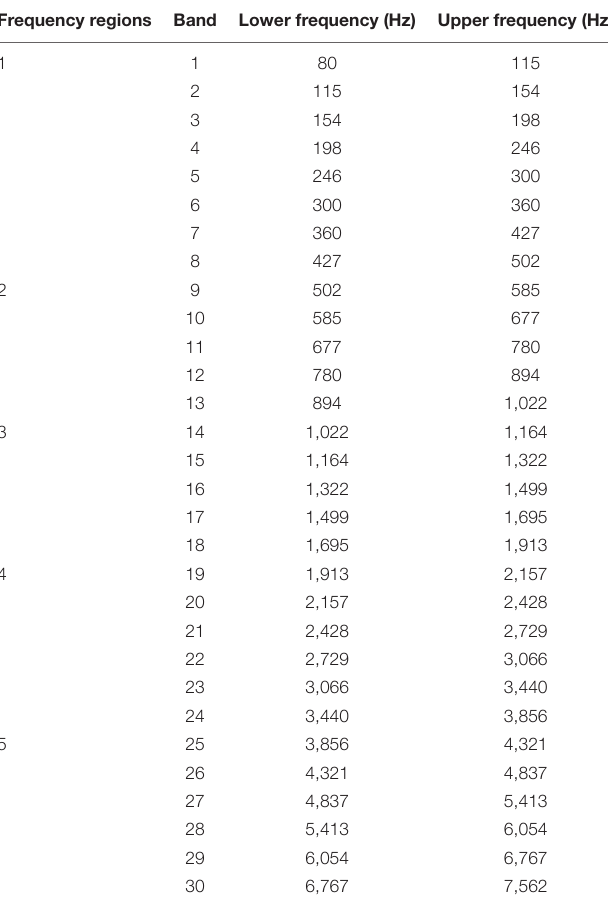
TABLE 1 | Cutoff frequencies of the 30 frequency